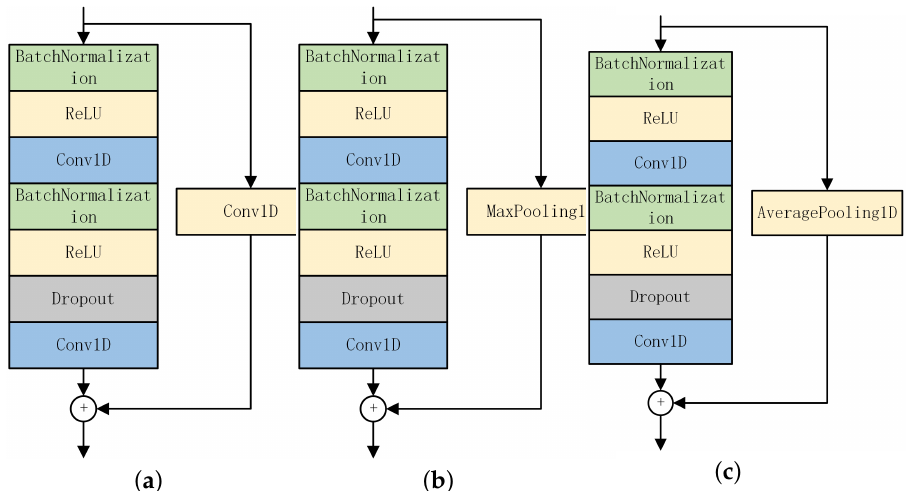
Figure 6. Convolutional neural network model structure: ( a ) DRN18 residual module structure;